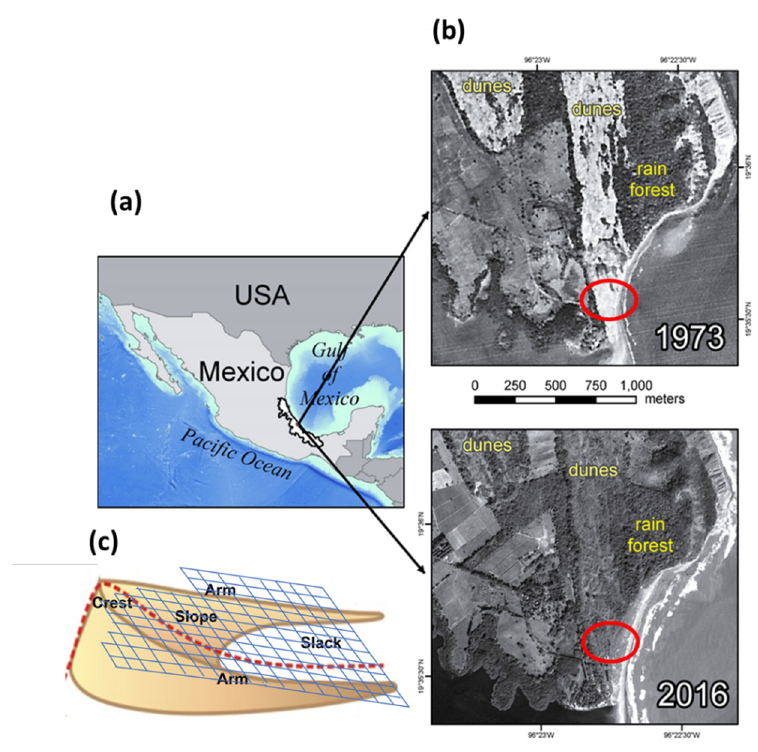
Figure 9. ( a ) Location of the study site. ( b ) Aerial images showing the initial mobility of the coastal dunes. Red circles show the approximate area where the permanent plots were placed for long-term monitoring. ( c ) The location of the grid and topographic elements where the sampled plots were placed. Red circles show the location of the study site within the reserve